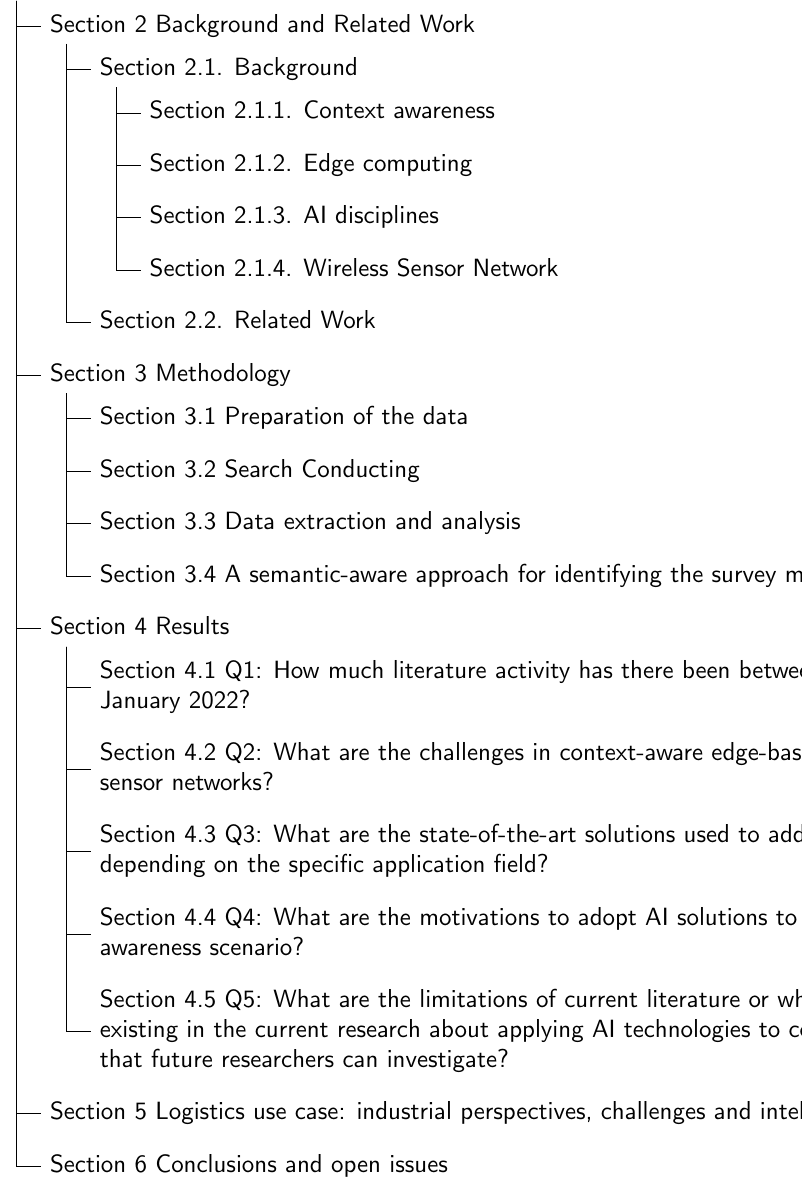
Figure 1. A schematic illustration of the paper